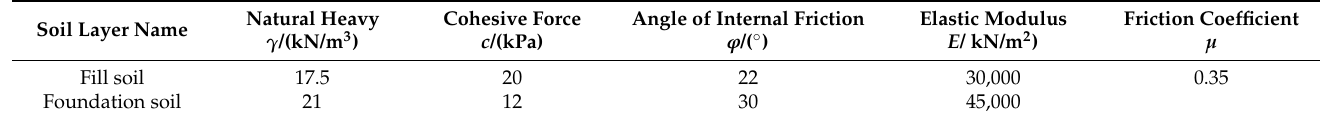
Table 4. Soil parameters of example 2.